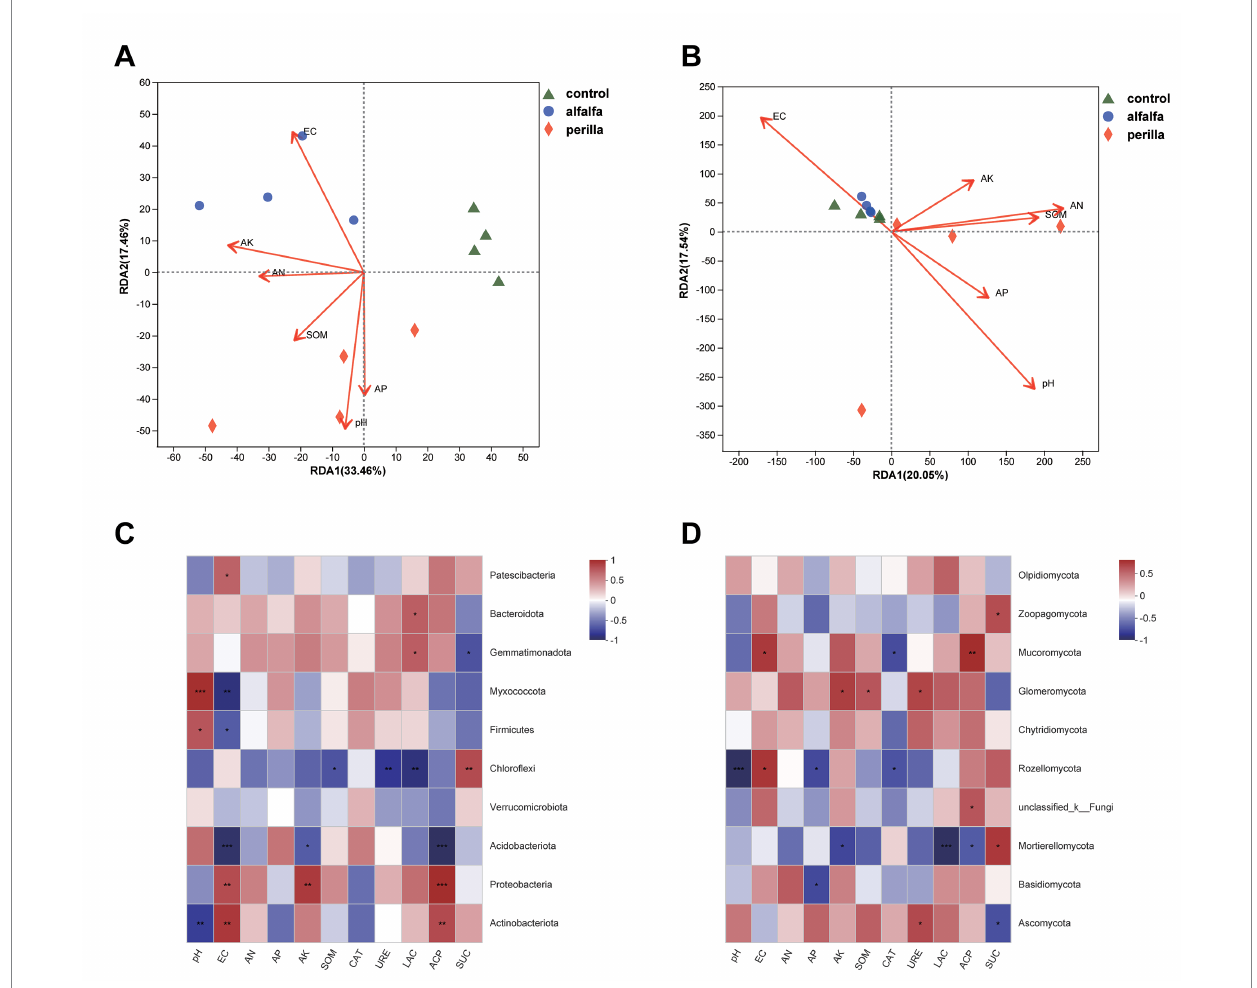
FIGURE 7 RDA analysis of (A) bacterial and (B) fungal and Pearson’s correlation analysis of (C) bacterial and (D) fungal with soil variables. “*,” “**,” and “***” indicate a significant difference at the p < 0.05, p < 0.01, and p < 0.001 level, respectively. Control, no treatment; Alfalfa, alfalfa cultivation; Perilla, perilla